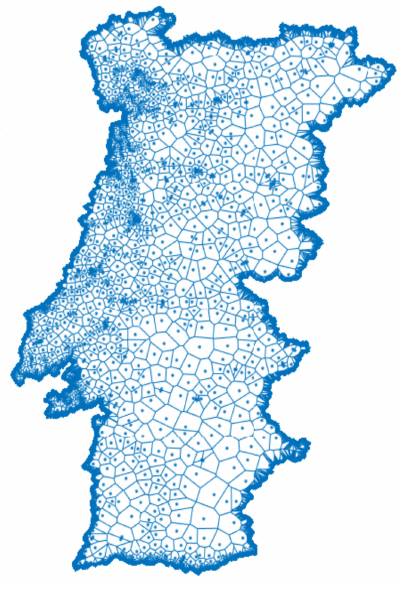
Figure 9. Generated Voronoi cells that indicate service coverage zones based on cell tower locations.